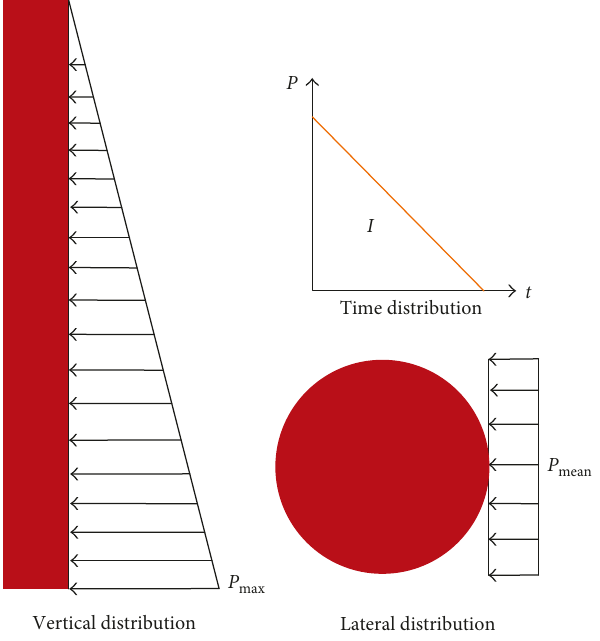
Figure 10: Blast loading model on the bridge